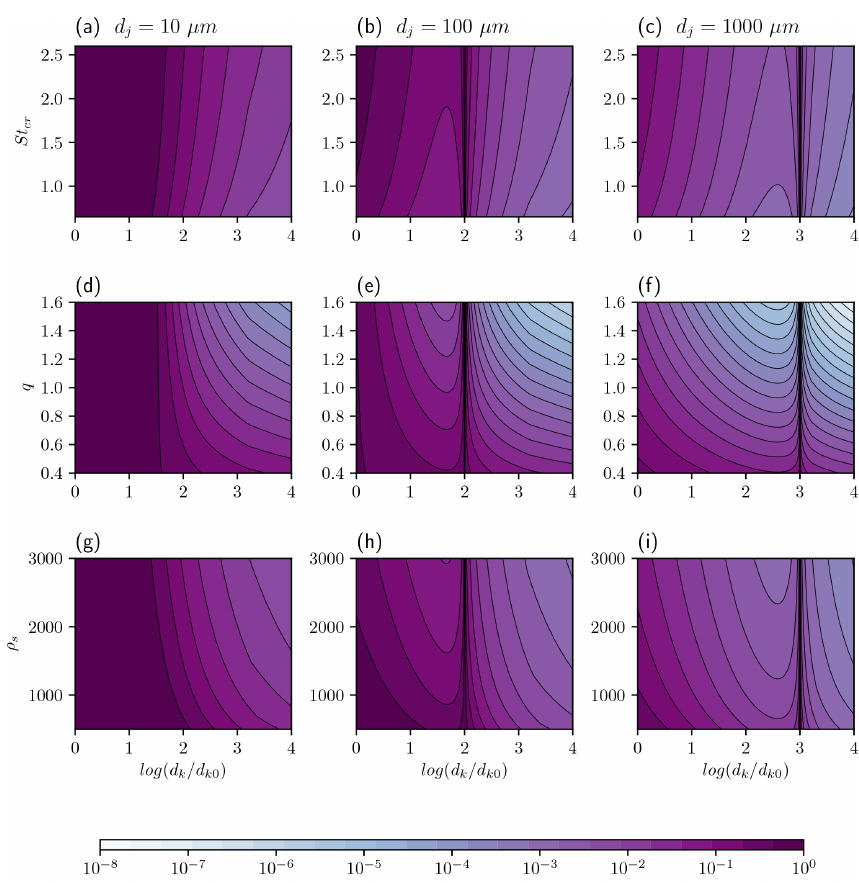
Figure 5. The variation in sticking efficiency ( α k,j ), with St cr (a–c) , q (d–f) , and ρ s (g–i) for three fixed values of d j , i.e. d j = 10µm (a, d, g) , d j = 100µm (b, e, h) , and d j = 1000µm (c, f, i) . The terminal velocity is calculated using Eqs. (29)–(31). The diameter d k 0 =